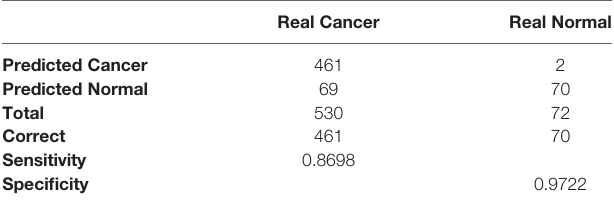
TABLE 2 | Sensitivity and speci fi city of diagnosis model. Real Cancer Real